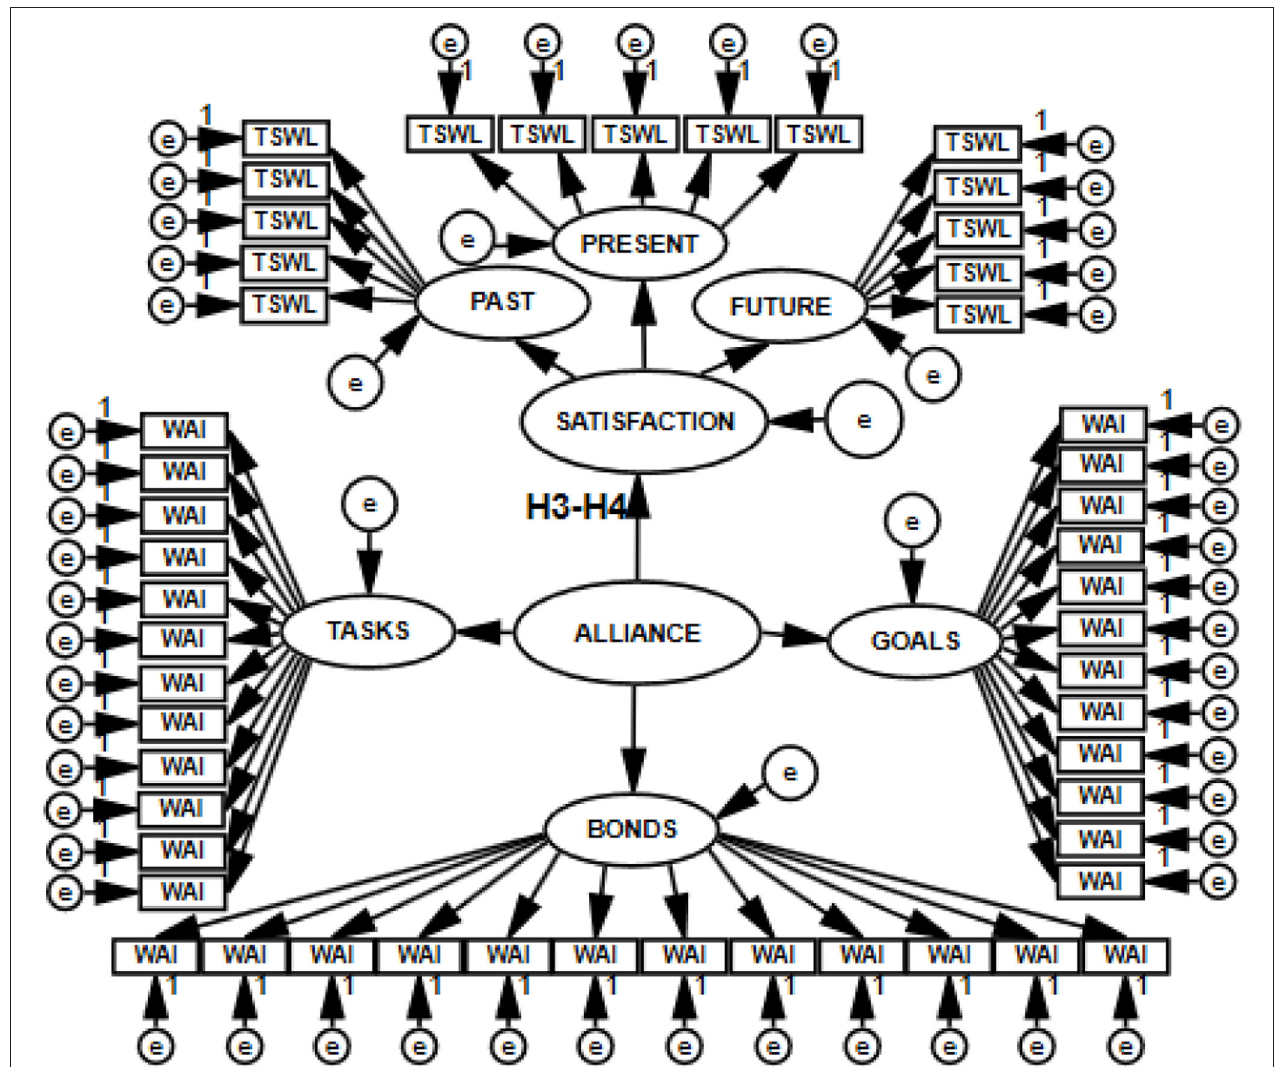
FIGURE 4 | Structural and measurement model with eight latent variables postulating the direction of relations between the working alliance and satisfaction with life, tested with